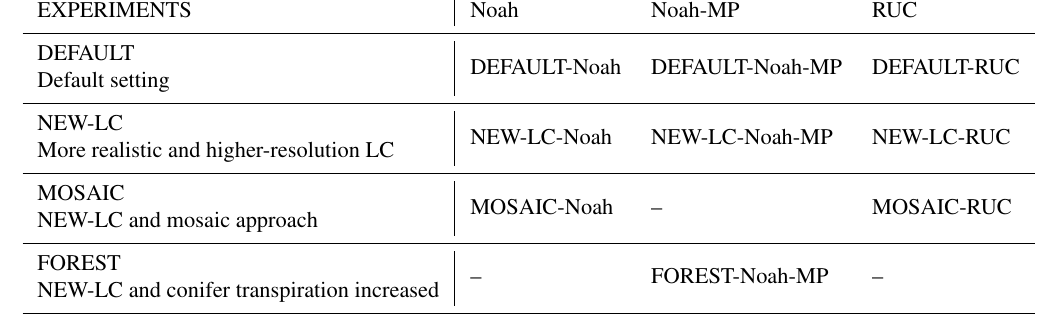
Table 2. Summary of the simulations and the names used throughout the paper. Note how some experiments were not possible (–) for some LSMs.